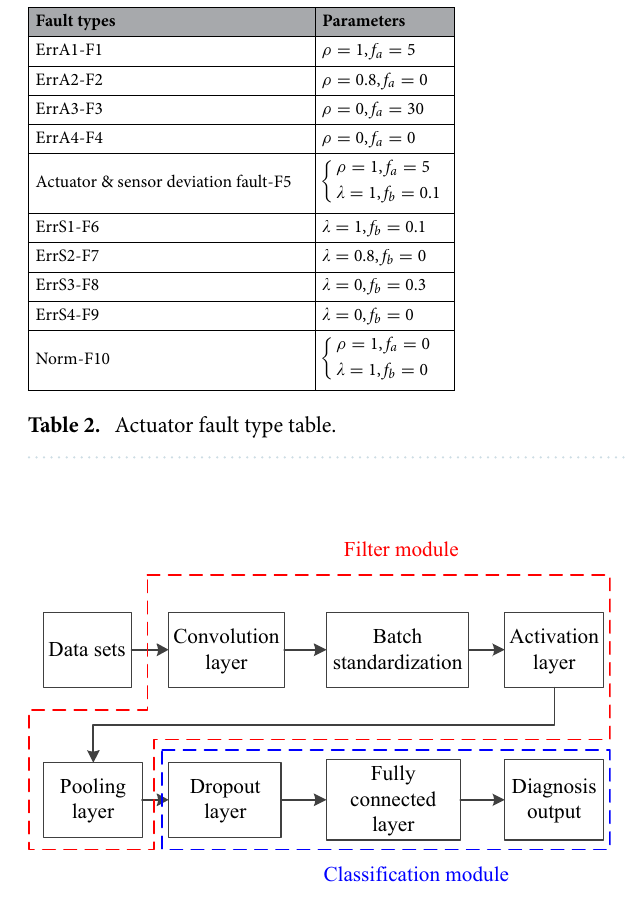
Figure 2. Diagram for CNN fault diagnosis